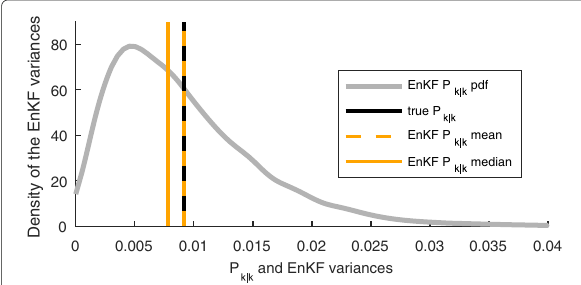
Fig. 2 Distribution of EnKF variances ¯ P k | k but computed with the correct Kalman gain. Otherwise, similar to Fig.